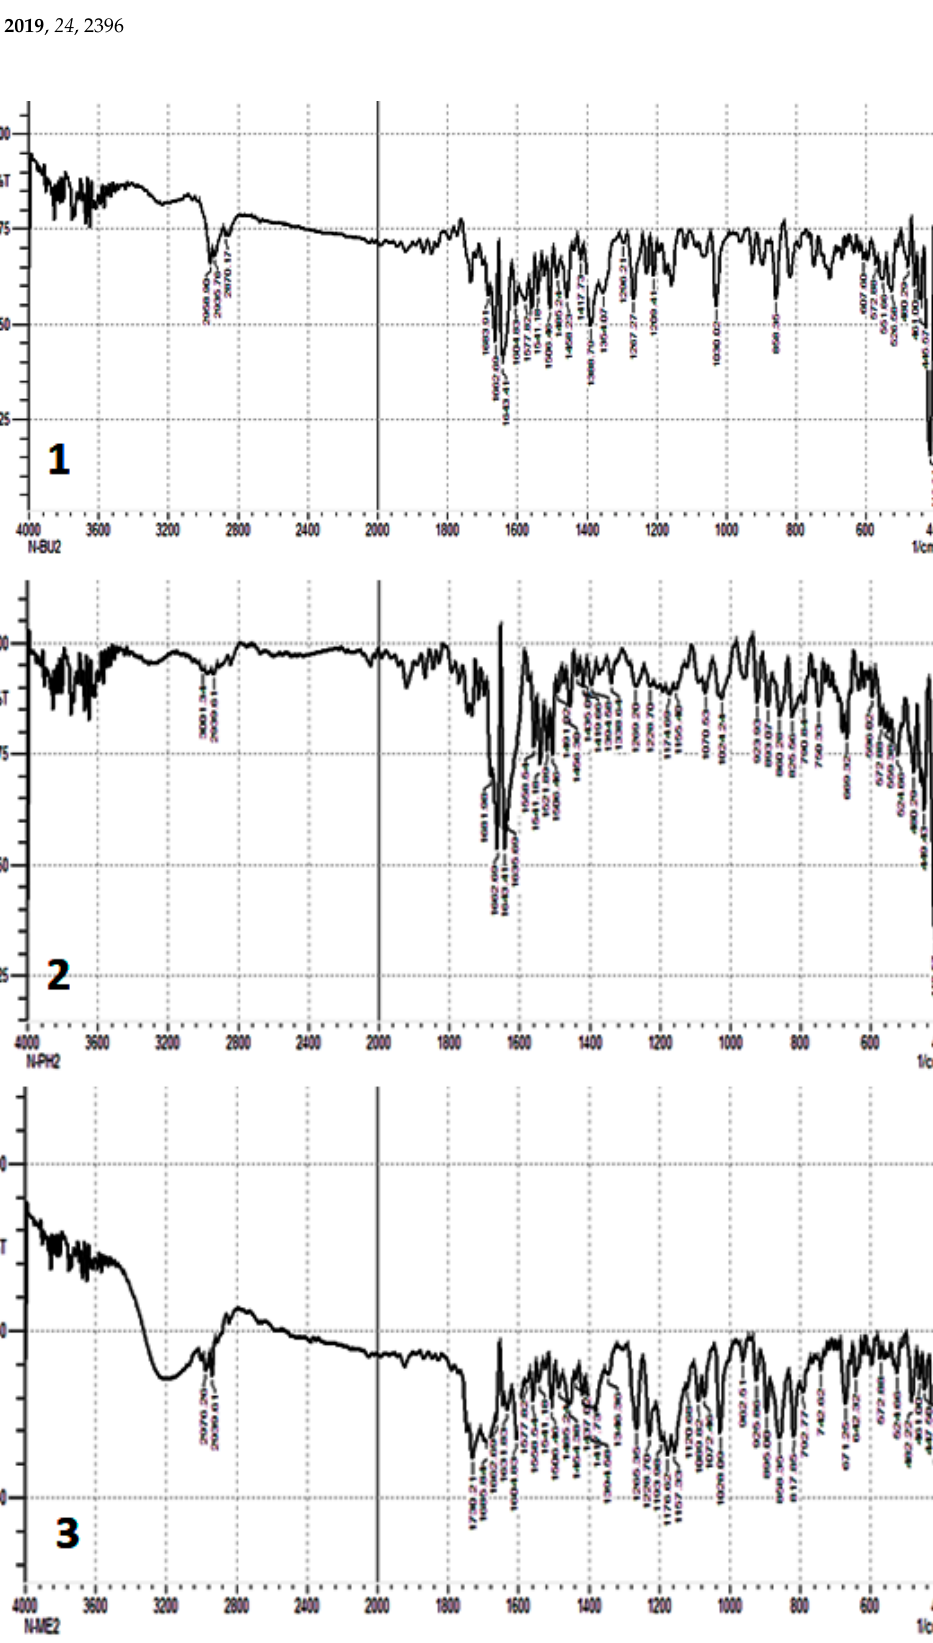
Figure 2. FT-IR spectra of Sn(IV) complexes 1 – 3 .